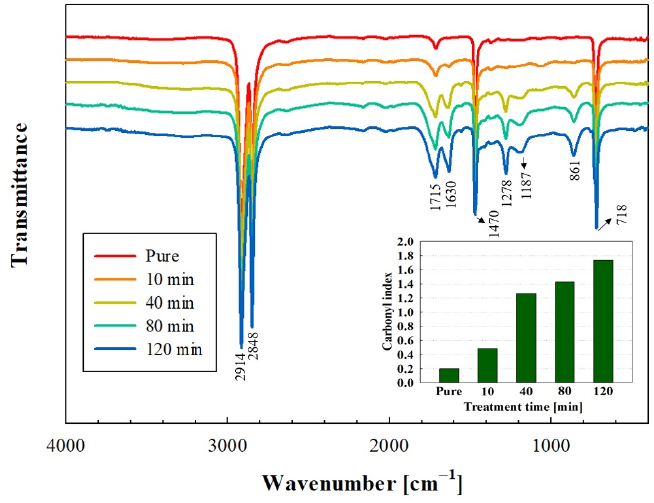
Figure 5. FTIR spectra of LDPE at different treatment times.